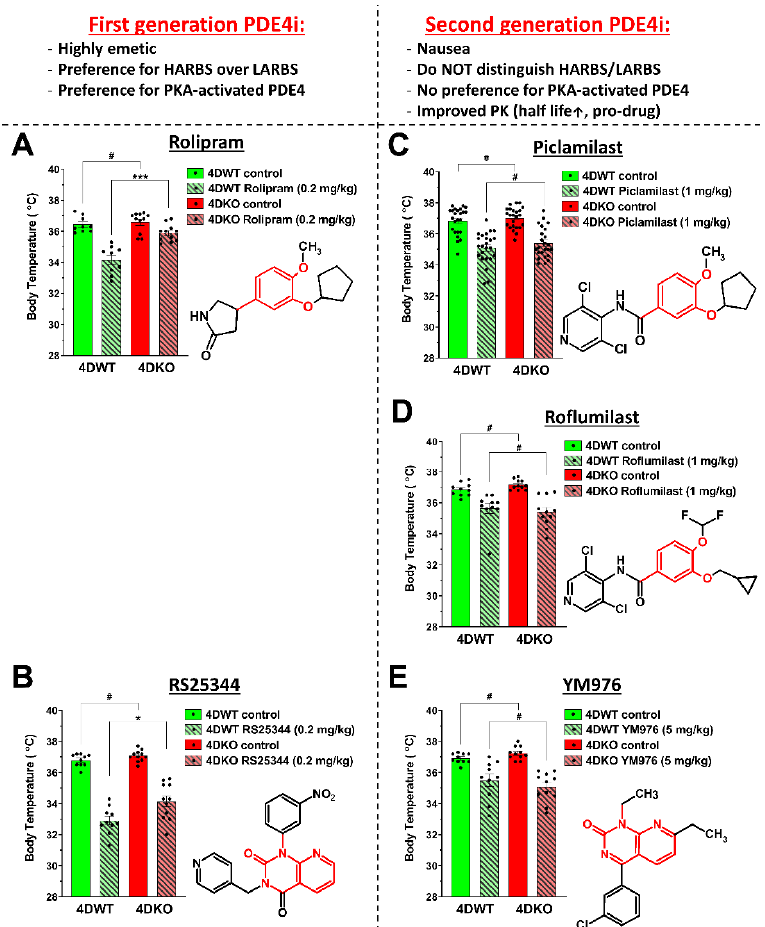
Figure 5. Genetic deletion of PDE4D in mice alleviates the hypothermia induced by first- generation PDE4 inhibitors Rolipram and RS25344 . ( A – E ) Core body temperatures of PDE4D knockout (4DKO) mice and their respective wildtype (4DWT) littermates were measured just prior to (control) and again 30 min after i.p. administration of the PAN-PDE4 inhibitors ( A ) Rolipram (0.2 mg/kg), ( B ) RS25344 (0.2 mg/kg), ( C ) Piclamilast/RP73401 (1 mg/kg), ( D ) Roflumilast (1 mg/kg) or ( E ) YM976 (5 mg/kg). Data represent the mean ± SEM. Statistical significance was determined using the Mann–Whitney test with 95% confidence interval and is indicated as # (p > 0.05; not significant), * ( p < 0.05) or *** ( p < 0.001). The chemical structures of the PAN-PDE4 inhibitors tested are shown for comparison. Compounds are grouped into the first-generation PDE4 inhibitors, Rolipram and RS25344 ( A , B ), on the left, and the second-generation PDE4 inhibitors, Piclamilast, Roflumilast and YM976 in ( C – E ), on the right. First-generation inhibitors are distinguished from second-generation drugs by high emetic potential, selectivity for HARBS (High-affinity Rolipram- binding state—a unique conformation of PDE4 proteins) and their preference for inhibition of PKA-phosphorylated/activated PDE4 [12,53,59,76]. While all listed PDE4 inhibitors do engage in paradigms that require brain-penetrance (e.g., anesthesia, hypokinesia, hypothermia [42,77]), the effects of Rolipram and RS25344 appear more rapid in onset and more potent compared to second- generation PAN-PDE4 inhibitors, suggesting that Rolipram and RS25344 exhibit a more rapid and profound